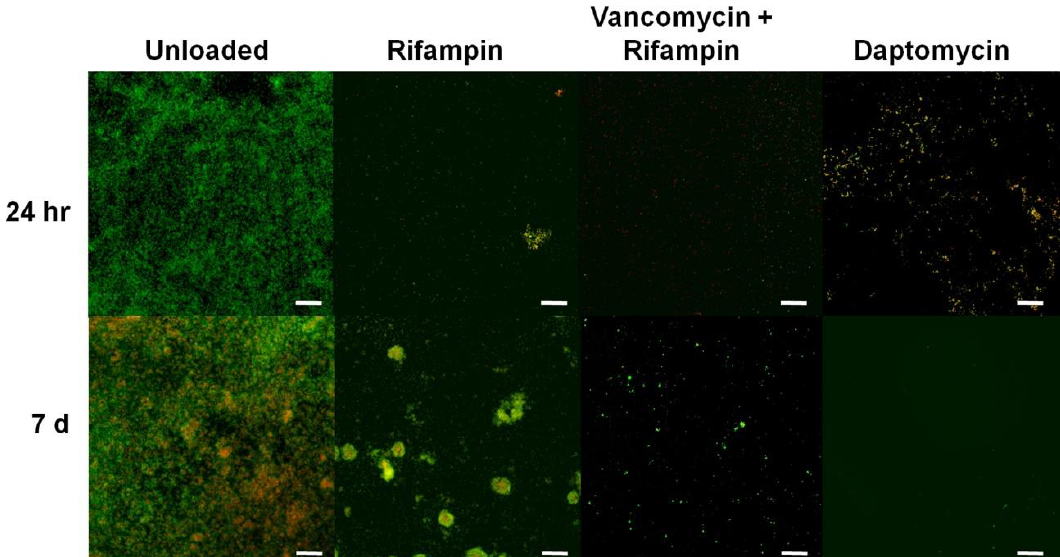
Figure 4. Representative CSLM images showing S. epidermidis ATCC 35984 biofilm (live cells stained green and dead and membrane compromised cells stained red or yellow) following treatment for 24 h and 1 week with unloaded beads (negative control) and beads loaded with rifampicin (Rifampin), rifampicin and vancomycin, and daptomycin. Scale bars: 25 µm.